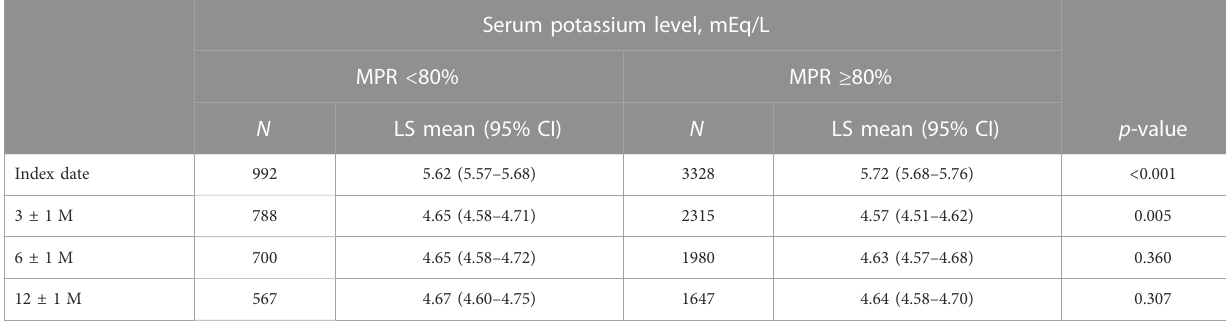
TABLE 4 Serum potassium levels at the index date and at 3, 6, and 12 months in patients strati fi ed by MPR (overall population). Serum potassium level,